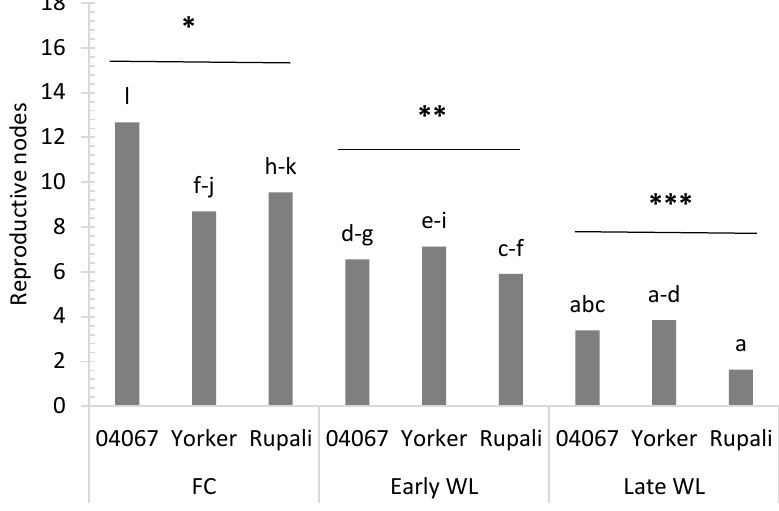
Figure 4. Main waterlogging (WL) and two-way genotype by WL effects on reproductive node count following WL treatments (field capacity (FC), early WL and late WL) for three chickpea genotypes. Letters indicate the significant difference in the two-way interaction ( p < 0.001). *, ** and *** indicate significant differences at the main effect level WL ( p < 0.001).